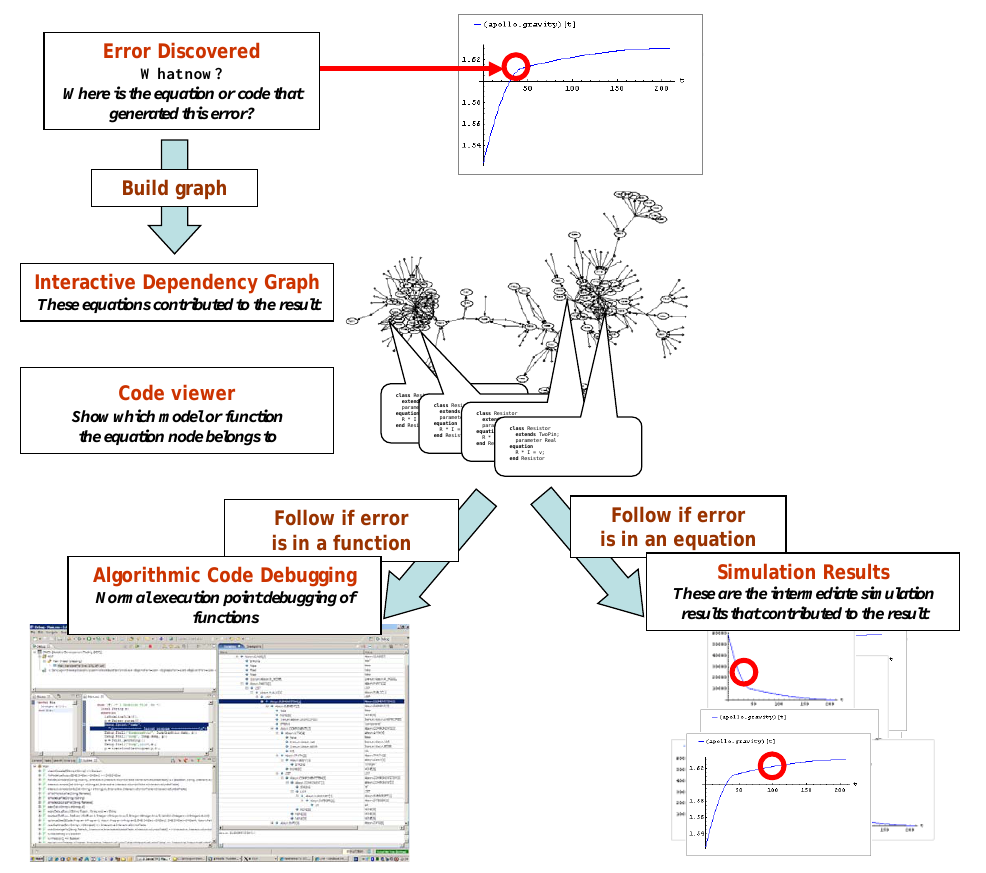
Figure 1: Integrated debugging approach